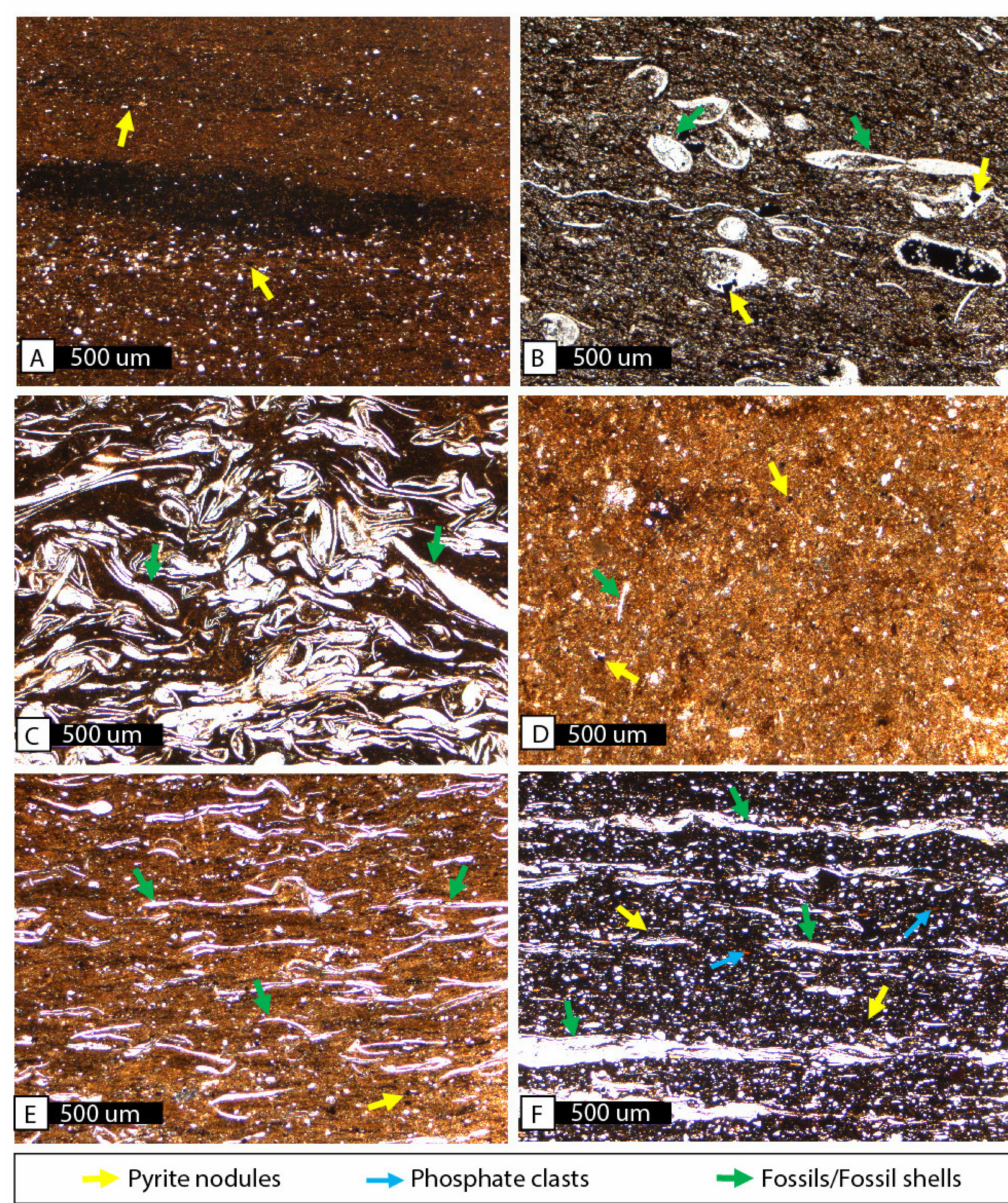
Figure 6. Plane light photomicrographs of the mudstone and carbonate lithofacies in lower part of the Oatka Creek Formation ( A – D ) and upper part of the Union Spring Formation ( E , F ). ( A ) Bedded argillaceous mudstone (BAM) facie not affected by bioturbation. ( B ) Bedded calcareous mudstone (BCaM). ( C ) Wackstone-packstone facies. ( D ) Bedded marlstone facies. ( E ) Bedded argillaceous mudstone (BAM) facies. ( F ) Bedded carbonaceous mudstone (BCM)